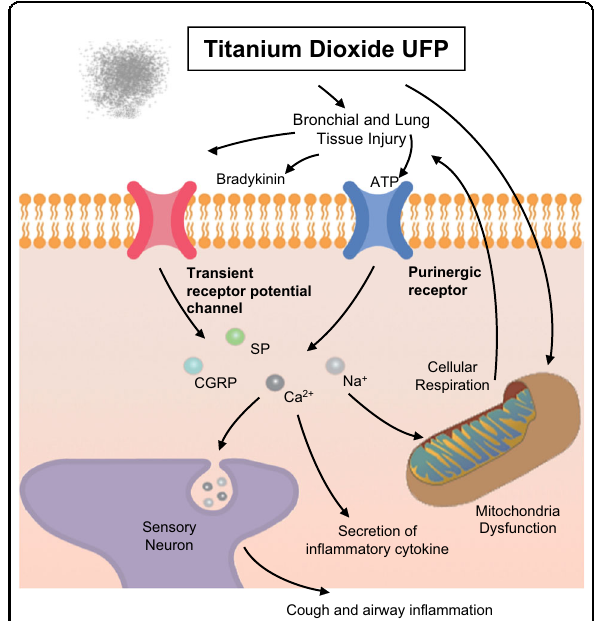
Fig. 5 PM exposure triggers neuroin fl ammation causing cough and airway in fl